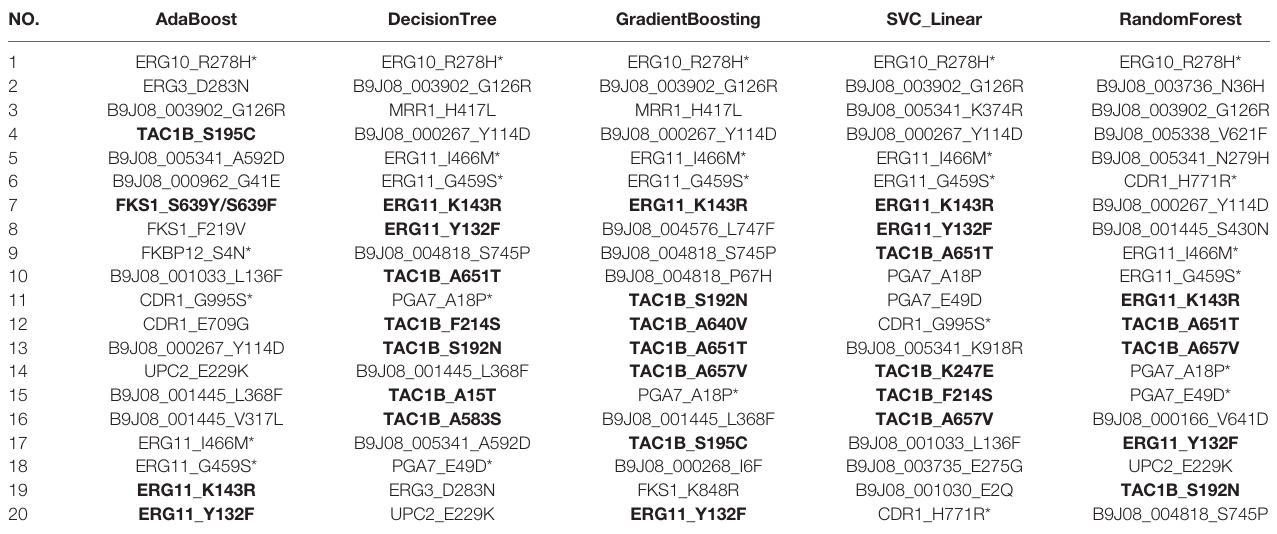
TABLE 4 | Top 20 mutations ranked by RFECV for AmB on F1